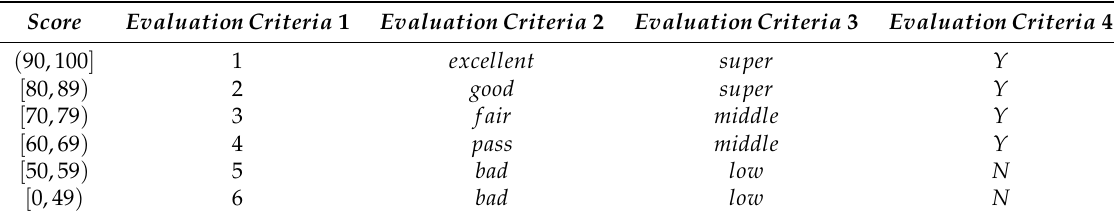
Table 2. Evaluation criteria.